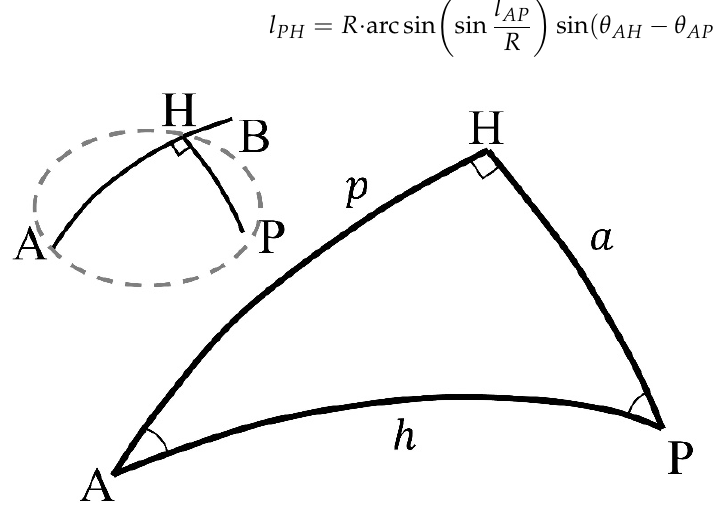
Figure 6. Spherical triangle for perpendicular